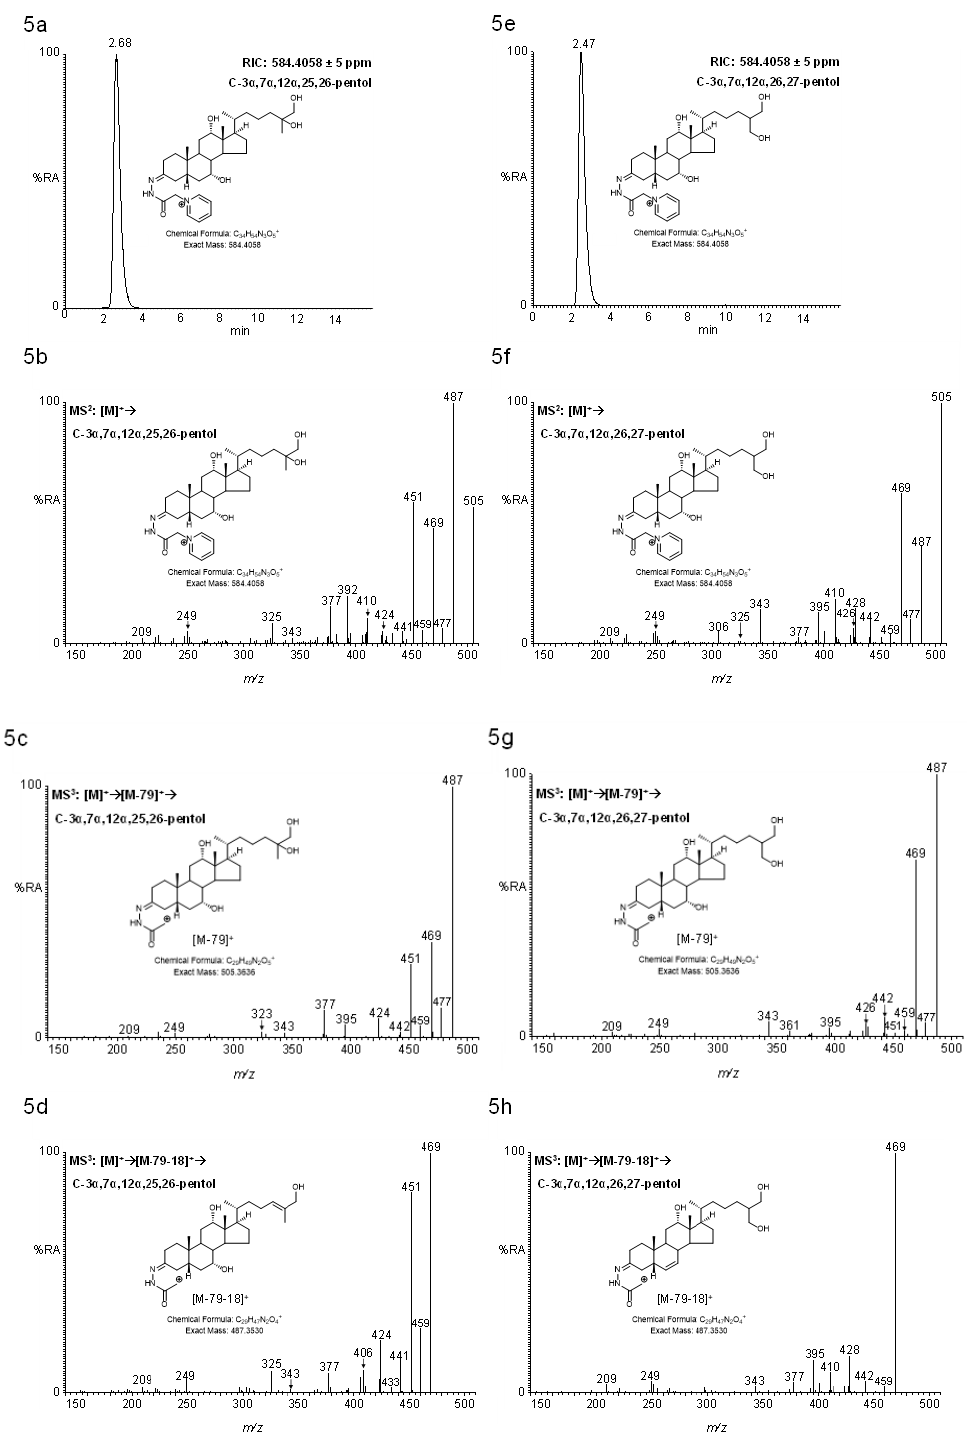
Figure 5. LC–(MS)MS n analysis of oxidized/GP-derivatized C-3 α ,7 α ,12 α ,25,26-pentol and Figure 5. LC – (MS)MS n analysis of oxidized/GP-derivatized C- 3α,7α,12α,25,26 -pentol and C- 3α,7α,12α,26,27 -pentol: ( a ) RIC, ( b ) MS 2 ([M] + → ), ( c ) MS 3 ([M] + → [M-Py] + → ), and ( d ) ([M] + → [M-Py- C-3 α ,7 α ,12 α ,26,27-pentol: ( a ) RIC, ( b ) MS 2 ([M] + → ), ( c ) MS 3 ([M] + → [M-Py] + → ),